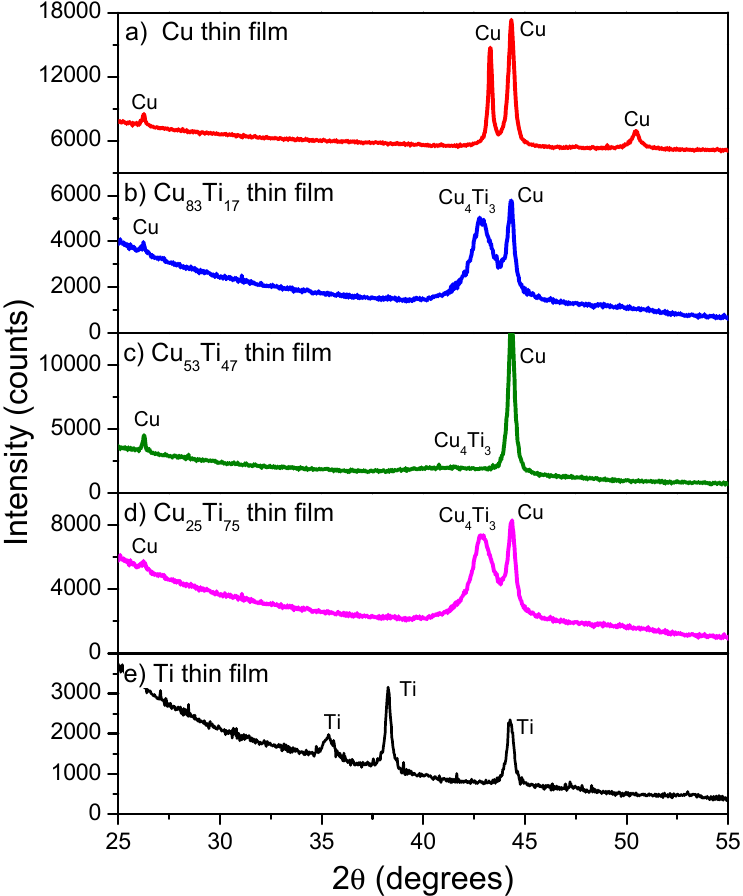
Figure 2. SEM images of prepared coatings: ( a ) Cu, ( b ) Cu 83 Ti 17 , ( c ) Cu 53 Ti 47 , ( d ) Cu 25 Ti 75 , and ( e ) Ti, as-deposited on Si substrates. Designations: (1) surface, and (2) cross-section.